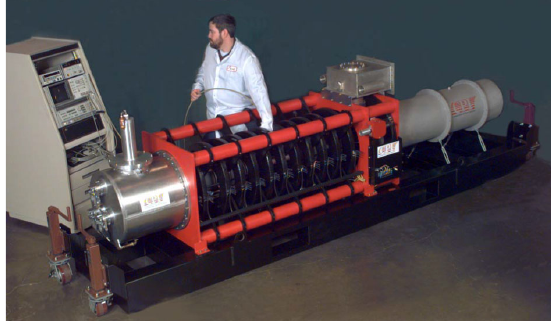
FIG. 24. MW-class, 700 MHz CW commercial klystron manu- factured by CPI (model VKP-7952)